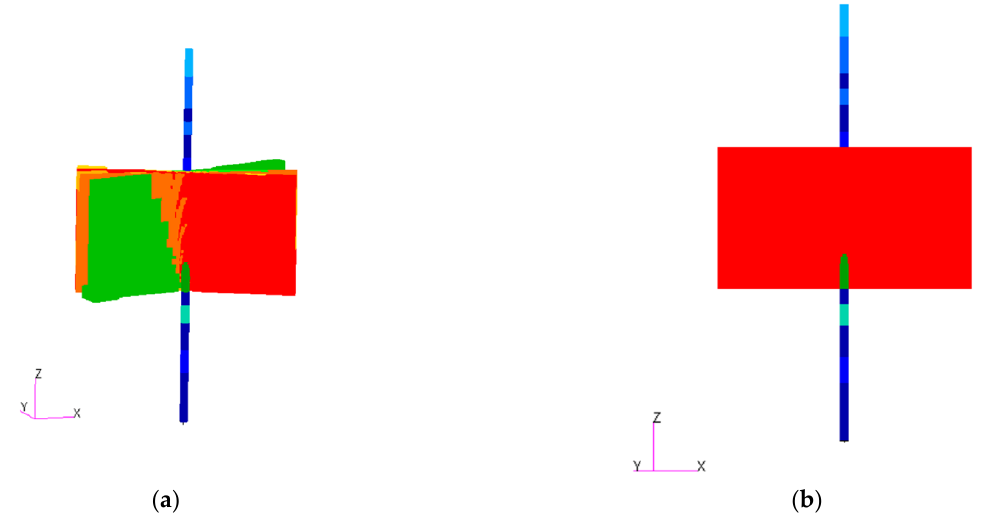
Figure 17. ( a ) Partial fracture networks near the wellbore area; ( b ) Partial single fracture near the wellbore area.